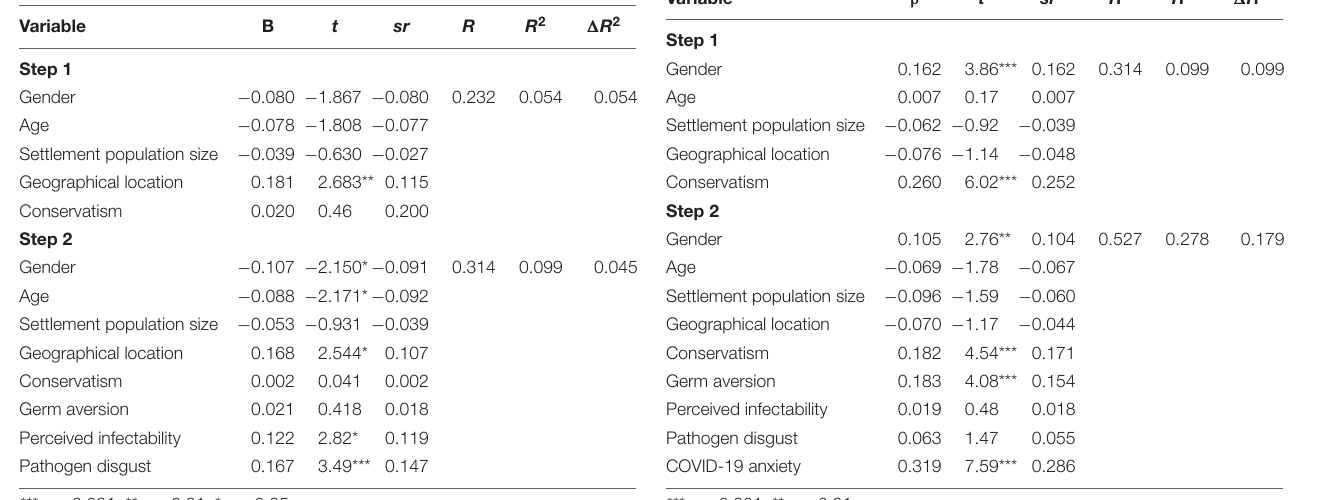
TABLE 1 | Summary of hierarchical regression analysis for variables predicting negative emotions toward